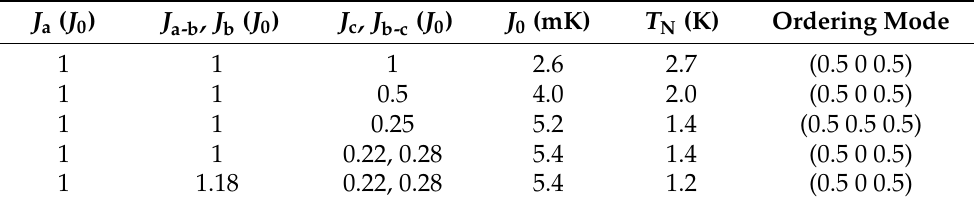
Table 8. The ordering temperature obtained from Monte Carlo simulation versus superexchange couplings between the nearest neighbour molecules. J 0 is obtained from the requirement to match the observed B 0 in the ordered